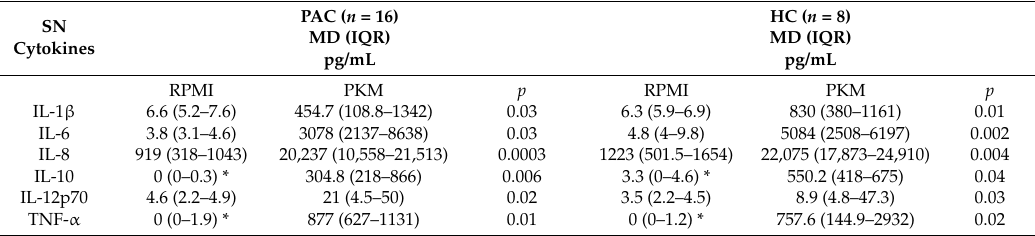
Figure 4. Determination of TNF- α and IL-10 secretion after B cell-stimulation. B cells were stimulated for 24 h with Pokeweed mitogen (PKM). After stimulation, supernatants were collected and cytokines measured by cytometric bead arrays. Significant differences were observed in IL-10 and TNF- α in both groups. Analysis of the IL-10/TNF- α ratio showed 1.2 times more TNF- α than IL-10 in PAC patients when compared with HC. The ratio was calculated using the mean values for IL-10 and TNF- α . See Table 4 for additional determined cytokines. Statistical differences were considered when p < 0.05.. Table 4. Supernatant (SN) cytokines after Pokeweed mitogen (PKM) stimuli in cells from patients with perennial allergic conjunctivitis (PAC) and healthy controls (HC).